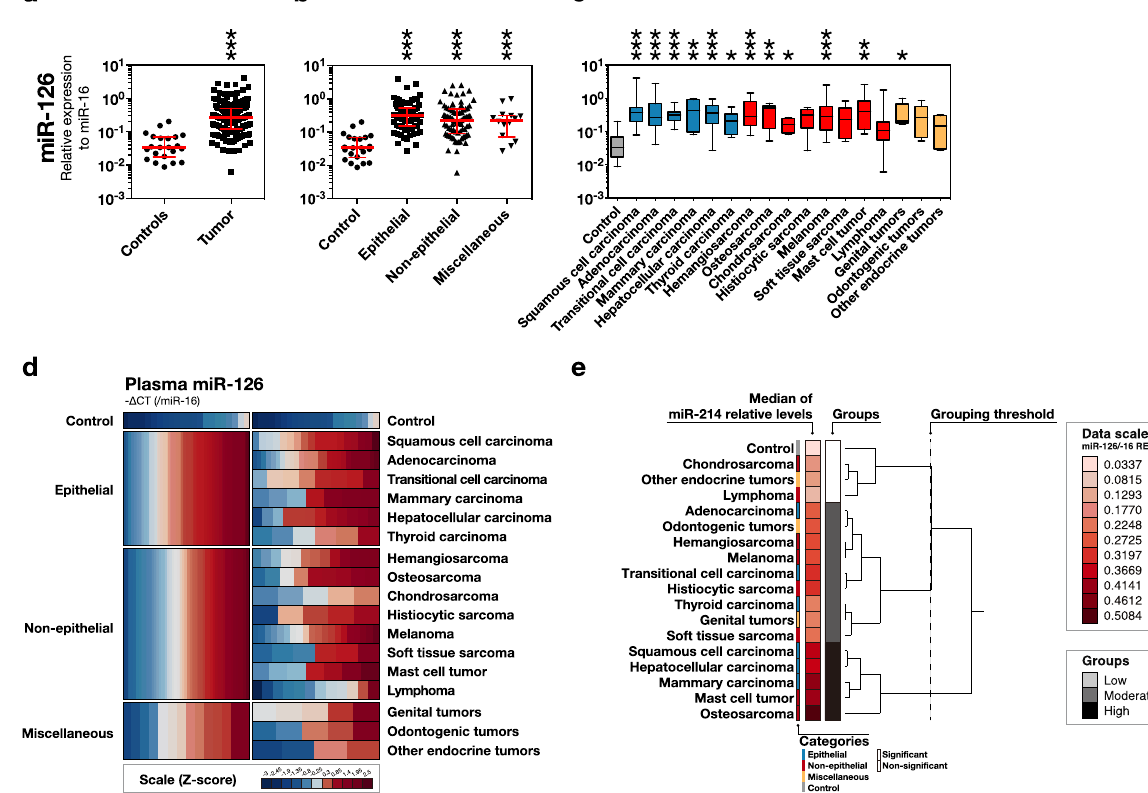
Figure 3. Profile of circulating miR-126 for canine tumours. Circulating miR-126 levels (- ∆ CT, relative to circulating miR-16 levels) were high in most of the tumour types. (a) Swarm plot of circulating miR-126 levels comparing tumour and controls. *** P < 0.001 (Mann-Whitney U test) (b) Swarm plot of circulating miR-126 levels comparing the groups of epithelial, non-epithelial, miscellaneous tumours, and controls. *** P < 0.001 (Steel’s Test) (c) Box plot of circulating miR-126 levels comparing the subcategories. * P < 0.05, ** P < 0.01, *** P < 0.001 (Steel’s Test). (d) Heatmap overview of circulating miR-126 levels. (e) Hierarchical cluster analysis of circulating miR-126 levels. The representative values used were the medians of miR-126 levels. The dendrogram was illustrated by Ward’s method, and categorised into 3 groups based on the indicated